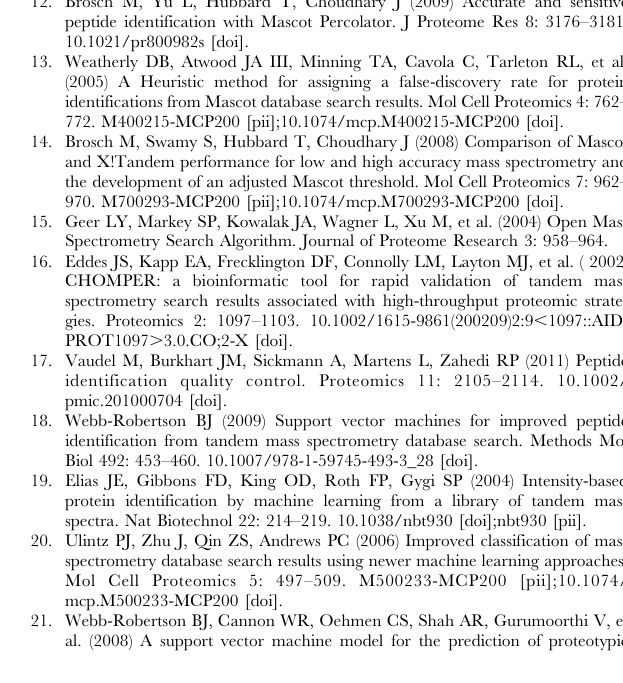
Figure S1 Mass bias trends for few more datasets. The figure shows the mass bias trend as shown for QTOF data in figure 1. This depicts the observation of the mass bias trend for different charge states in few more datasets. This observation is repeatable and forms the basis of FlexiFDR. Figure S2 Comparison of spectra and peptides assigned by FDR and FlexiFDR for separate search. Comparison of spectra and peptides assigned by FDR (pink) and FlexiFDR (blue) for separate database search. The number of spectra is shown on top with the number peptides in brackets beneath them. For the standard mixtures, the true positives (green) and false positives (red) identified exclusively are highlighted. FlexiFDR identifies a higher number of true unique spectra and peptides than FDR in almost all cases. The proportion of false positives in exclusively identified set is higher in FDR than FlexiFDR. A star symbol (*) depicts that although there are non-zero true positive spectra identifications in few cases of FDR, they could not bring in any new peptide identification. The peptides they identified were already identified by other spectra (which are shared by both FDR and FlexiFDR). Figure S3 Comparison of unique identifications (spec- tra and peptides) from separate search. Top and Bottom panels depict spectra and corresponding peptide comparison from a separate search. The blue colored bars represent the unique true hits added by FlexiFDR alone while green colored bars represent unique true hits from FDR alone. Similarly, the pink bars denote false hits from FlexiFDR alone while red bars denote false hits from FDR alone. The spectral hits from FDR can be mapped to unique peptides right in the lower panel. The false spectral hits in case of FDR alone bring more false peptide identifications than FlexiFDR (compare bars from A to B vertically). FlexiFDR brings more unique true hits than FDR and brings lesser number of